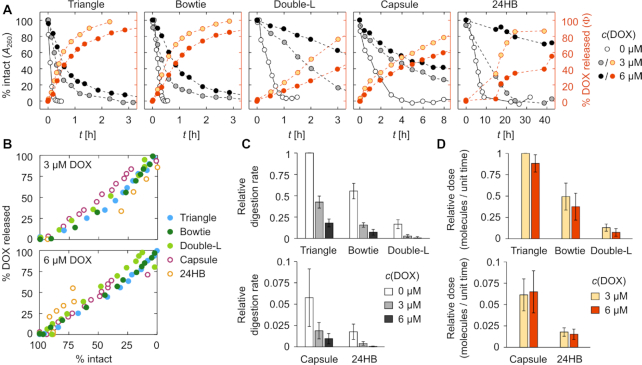
DNase I digestion of the DONs and the subsequent DOX release. (A) Representative (n = 1) digestion and DOX release profiles of the studied DONs at different DOX loading concentrations, after introducing 34 U ml−1 DNase I into the sample at t = 0. The structural integrity of the DONs (\documentclass[12pt]{minimal}
\usepackage{amsmath}
\usepackage{wasysym}
\usepackage{amsfonts}
\usepackage{amssymb}
\usepackage{amsbsy}
\usepackage{upgreek}
\usepackage{mathrsfs}
\setlength{\oddsidemargin}{-69pt}
\begin{document}
}{}$\%$\end{document} intact) has been determined from the increase of the A260 signal, and shown with the white, gray, and black markers depending on the DOX concentration (0, 3 or 6 μM). For samples containing 3 or 6 μM DOX, the DOX release (\documentclass[12pt]{minimal}
\usepackage{amsmath}
\usepackage{wasysym}
\usepackage{amsfonts}
\usepackage{amssymb}
\usepackage{amsbsy}
\usepackage{upgreek}
\usepackage{mathrsfs}
\setlength{\oddsidemargin}{-69pt}
\begin{document}
}{}$\%$\end{document} DOX released) is shown with the light and dark orange markers and represents the percentage of initially bound molecules that have been released due to the digestion. \documentclass[12pt]{minimal}
\usepackage{amsmath}
\usepackage{wasysym}
\usepackage{amsfonts}
\usepackage{amssymb}
\usepackage{amsbsy}
\usepackage{upgreek}
\usepackage{mathrsfs}
\setlength{\oddsidemargin}{-69pt}
\begin{document}
}{}$\%$\end{document} DOX released has been determined from the recovery of the fluorescence quantum yield of DOX. (B) The cross-correlation between % DOX released and % intact for all DONs at 3 and 6 μM DOX loading concentration. (C) DNase I digestion rates of the DONs at 0, 3 or 6 μM DOX loading concentration. All digestion rates are shown relative to the triangle DON at 0 μM DOX concentration, and have been averaged from the digestion rates determined from three individual measurements; expressed as the mean ± standard error. (D) DOX release rates of the DONs at 3 and 6 μM DOX loading concentration. Relative dose stands for the absolute number of DOX molecules released per unit of time. All values are expressed as the mean ± standard error (n = 3).